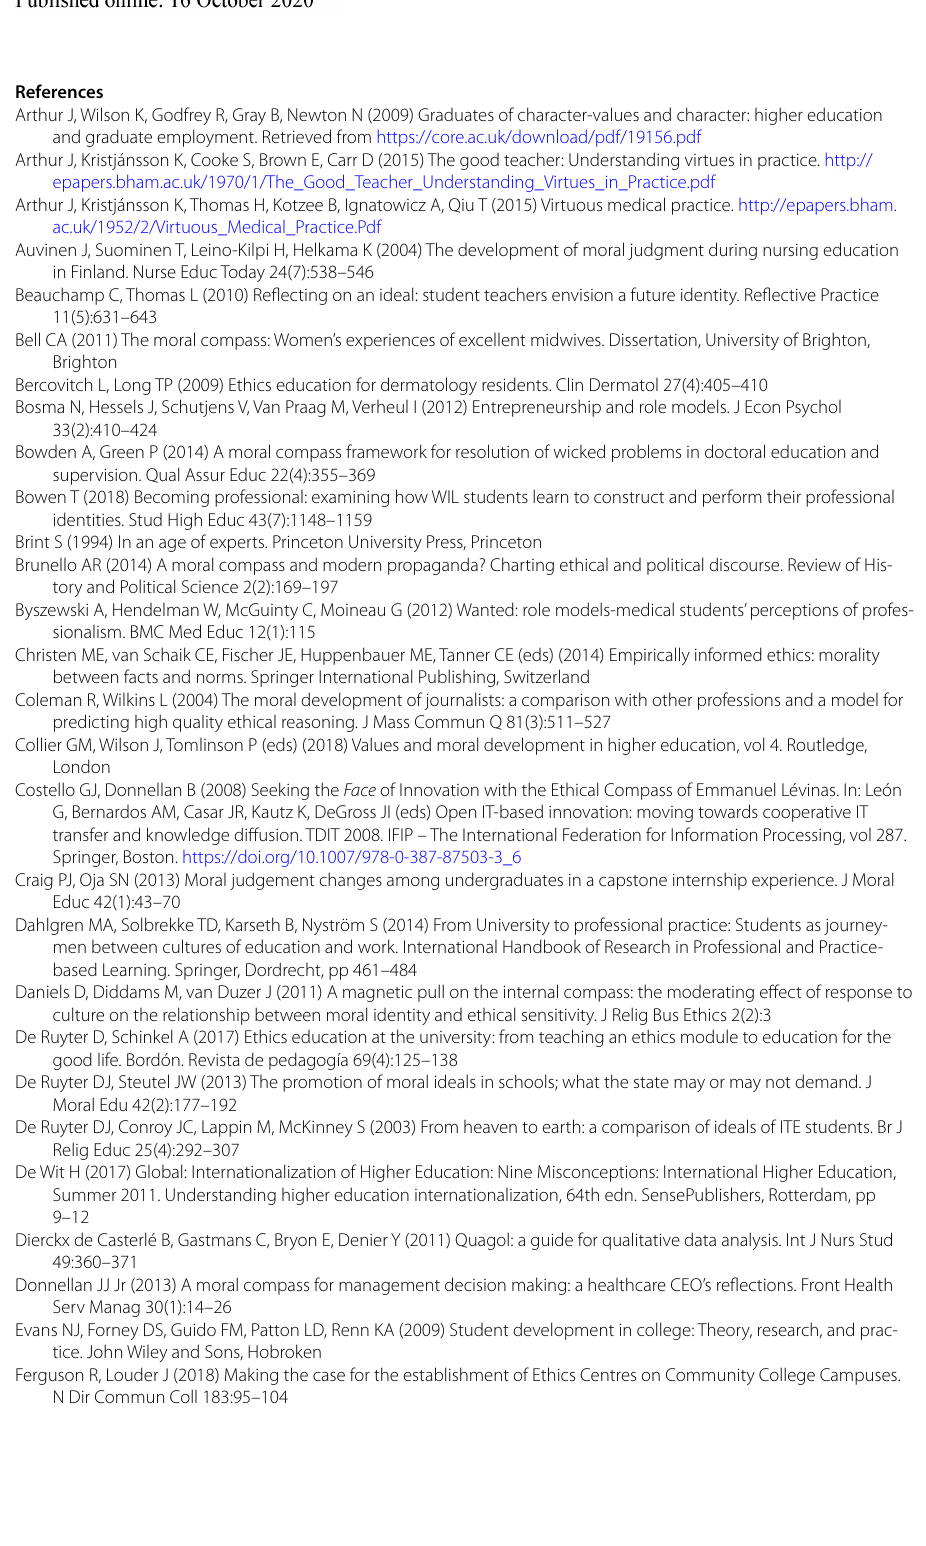
The words refer to action and consequences (e.g., booking results), rules (compliance with a professional code), character (e.g., practising virtues), self-care (e.g., being autonomous) and contains general concepts (e.g.,